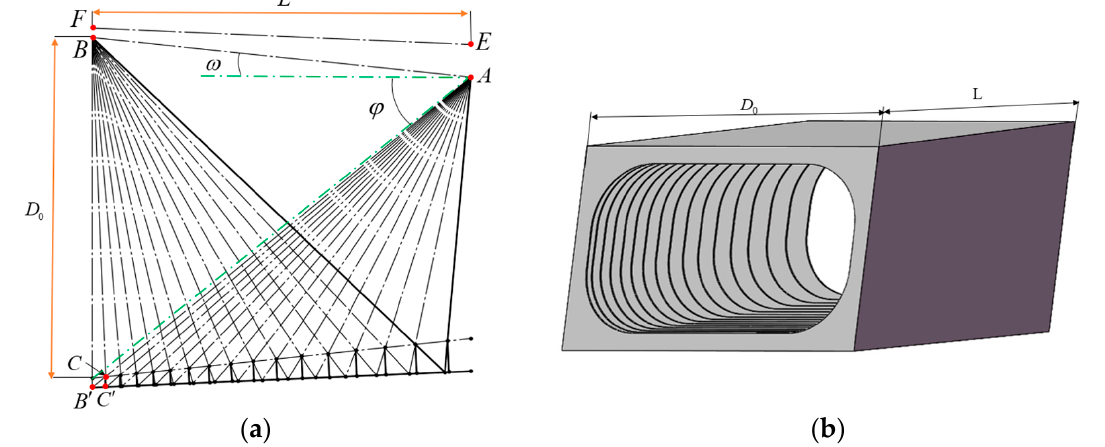
Figure 3. Design result of the front baffle. ( a ) Design principle of the baffle vane; ( b ) structure model of the front baffle.